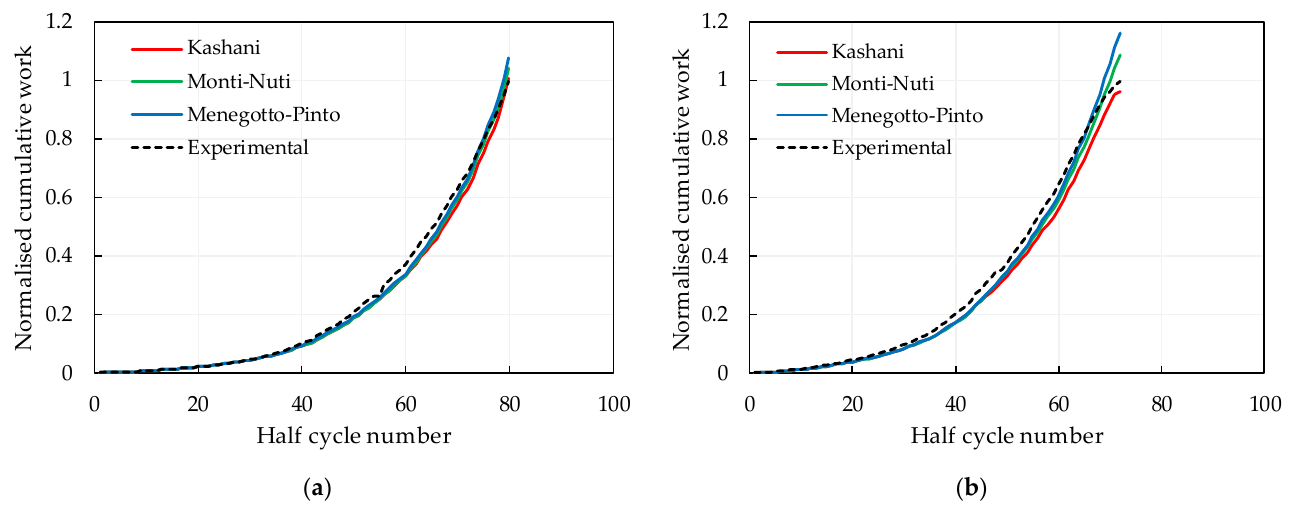
Figure 6. Comparison between the experimental and numerical responses in terms of energy dissipation capacity: ( a ) un-corroded column, ( b ) corroded column.